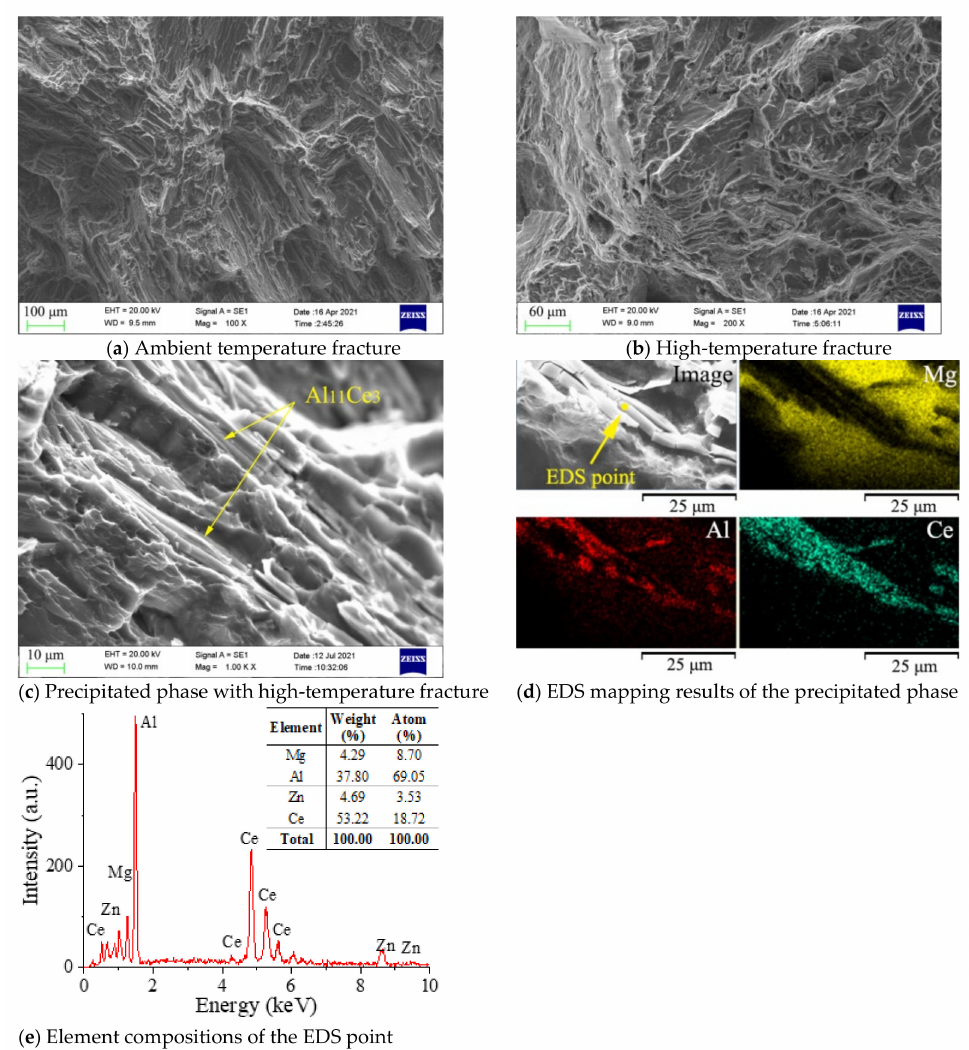
Figure 12. Fracture morphology of the sample with 0.2 wt.%